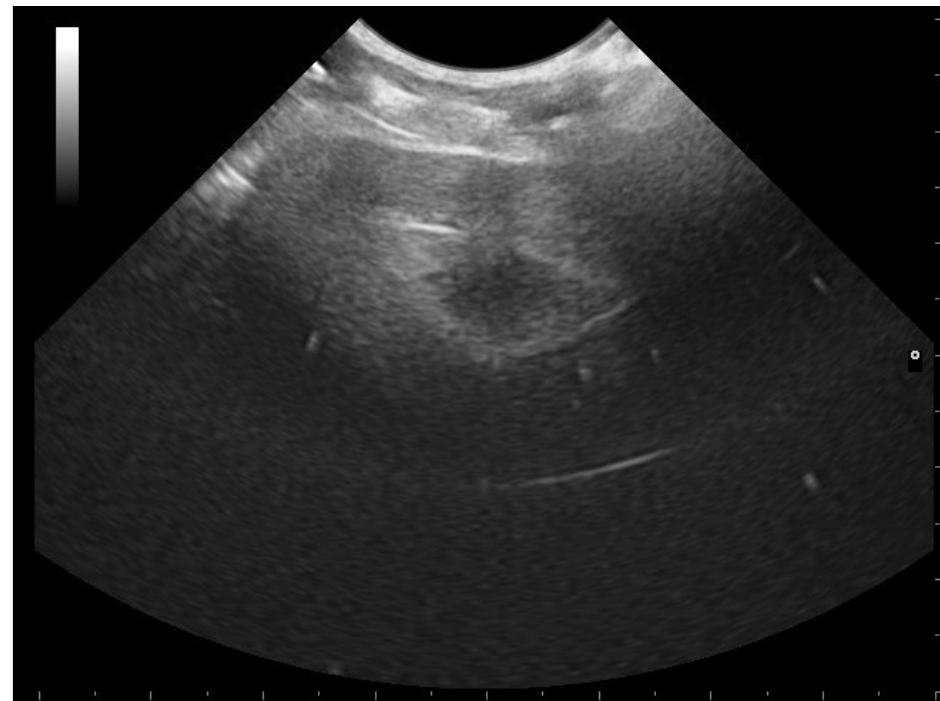
Figure 6. Follicle highlighted in a female boa 23 days after ovulation. An oval shape is shown, and the central anechoic area is highlightable in all females who have given birth to living and viable offspring.